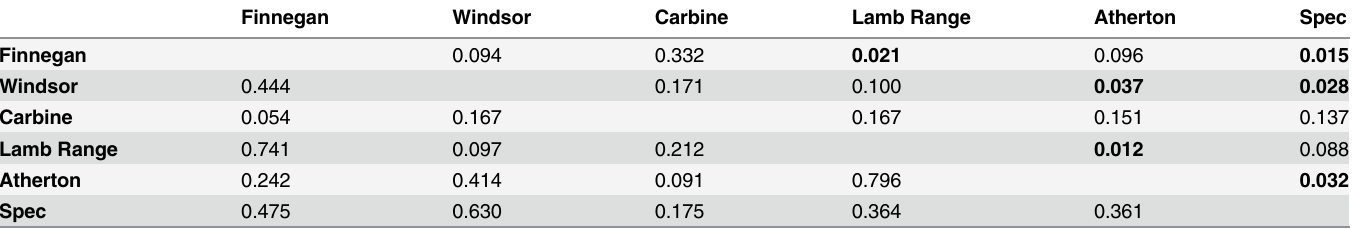
Table 2. ANOSIM results from comparisons of site species composition between each pair of subregions based on species frequency in 2011/ 2012 wet season samples. Numbers below the diagonal are dissimilarity indices, and those above are P values (P < 0.05 in